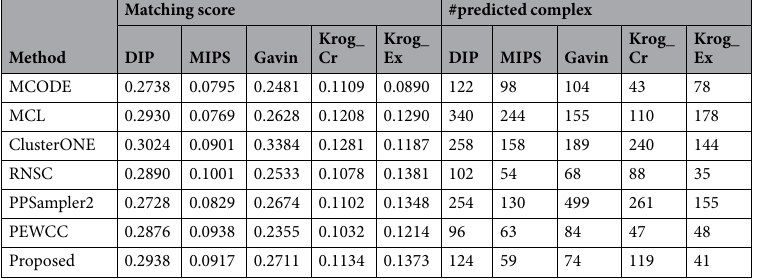
Table 2. Comparisons of performance of different algorithms using matching score. Krog_Cr and Krog_Ex are the Krogan_Core and Krogan_Extended data sets respectively. Third column represents number of predicted complexes in each